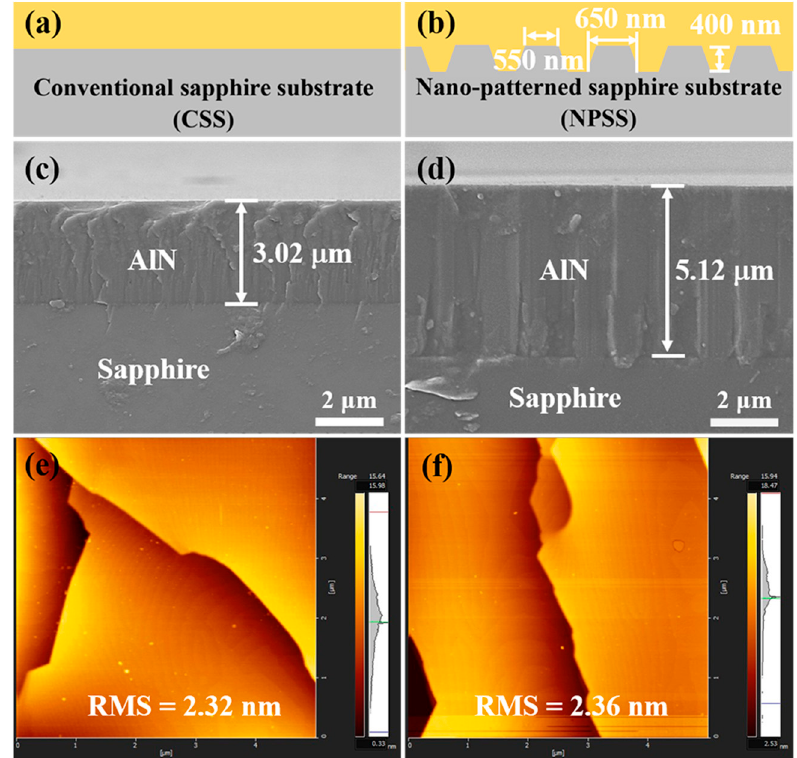
Figure 1. Schematic diagram of ( a ) conventional sapphire substrate and ( b ) nano ‐ patterned sapphire substrate. Morphology scanning electron microscopy (SEM) cross ‐ section images of AlN/sapphire films: ( c ) sample A and ( d ) sample B. Atomic force microscopy (AFM) surface micrographs are shown in ( e ) sample A and ( f ) sample B. Table 1. Summary of growth information and thickness of AlN samples. Sample